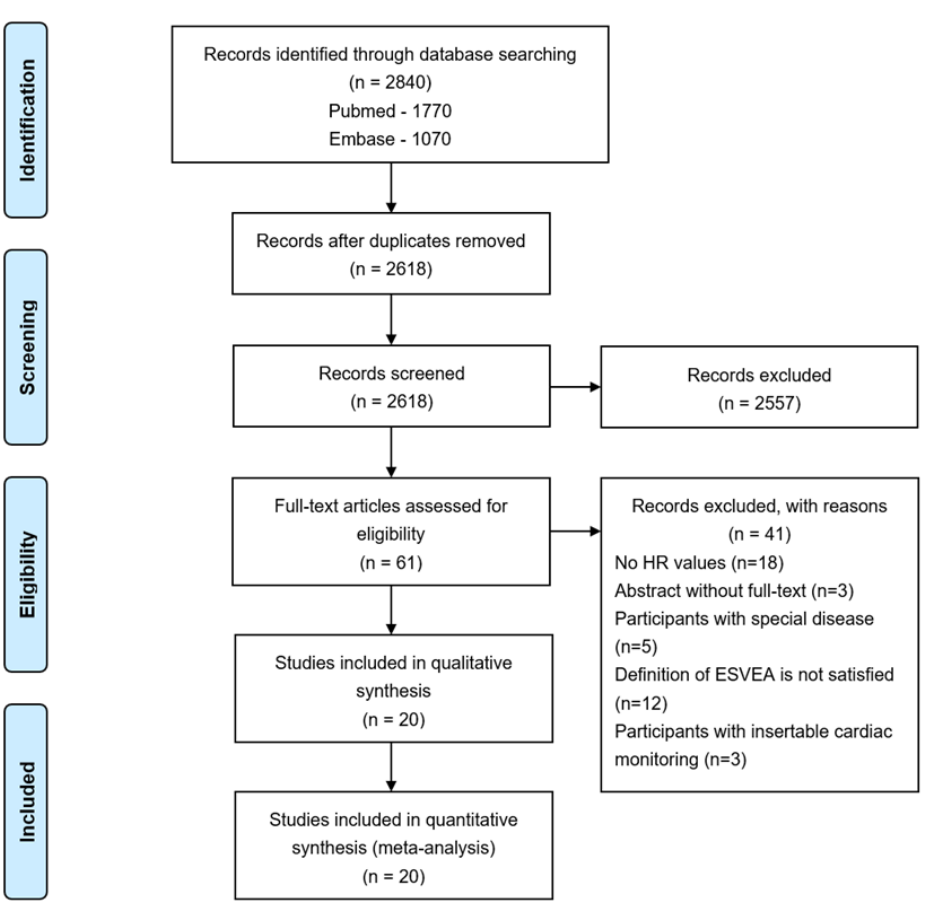
Figure 1. PRISMA flowchart. Abbreviations: HR—hazard ratio; ESVEA—excessive supraventricular ectopic activity.